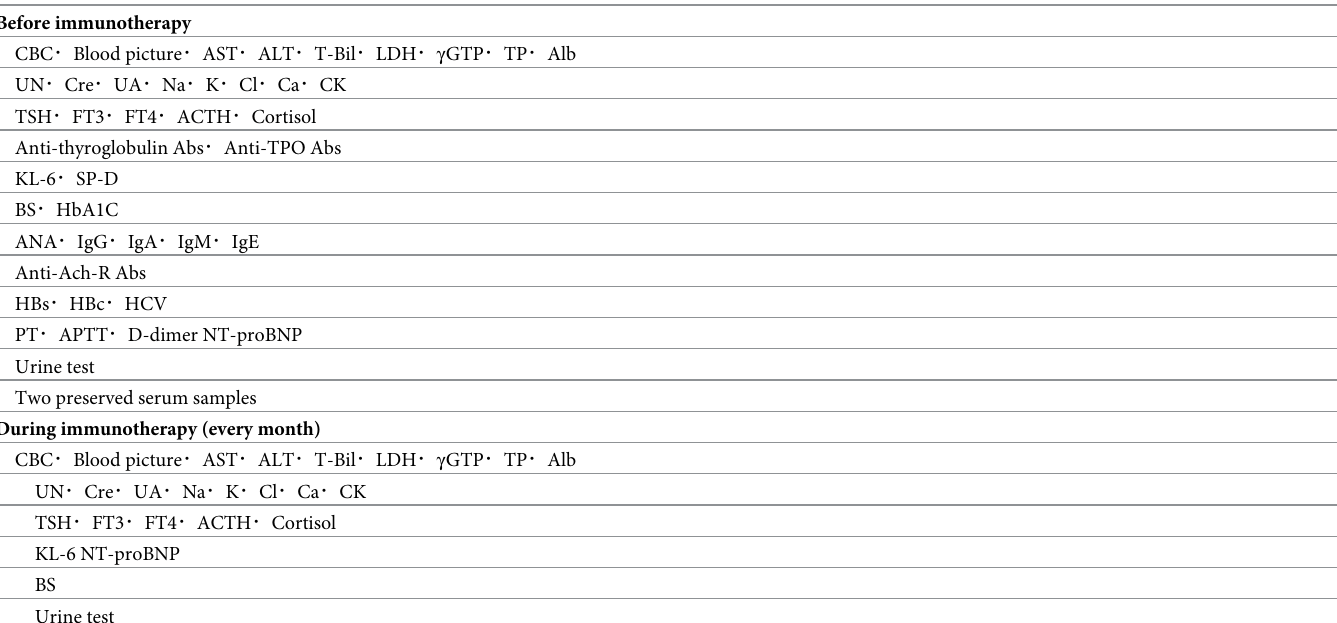
Table 1. Examination details. Before immunotherapy